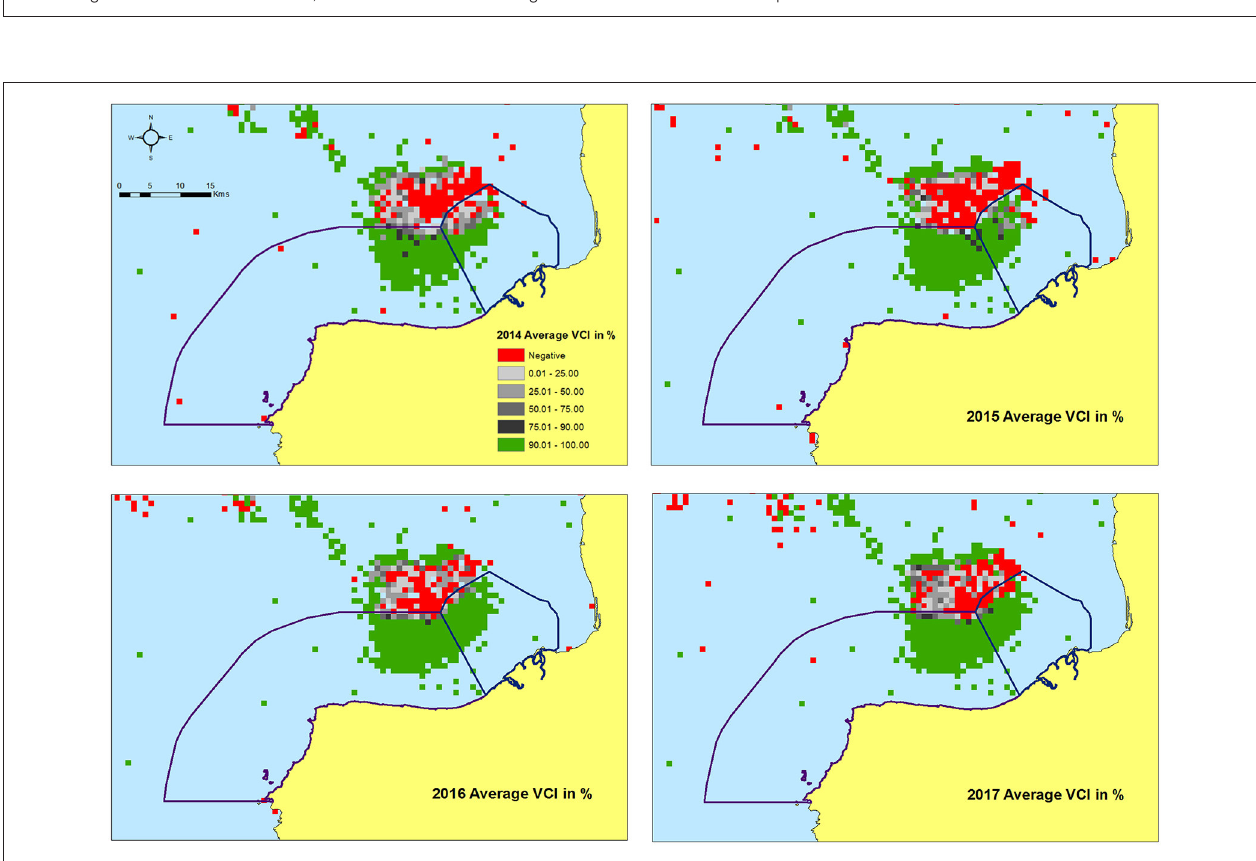
FIGURE 9 | Gridded VCI for the Cauayan and Ilog municipal water closures. The closures were highly effective in each year, with the exception of the narrow strip inside the outer boundary.